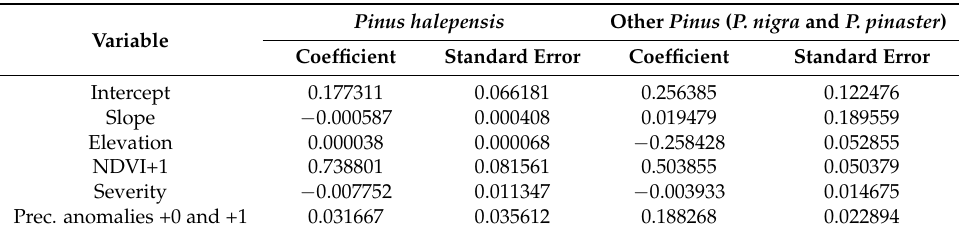
Table 7. GWR results at 95% confidence interval.